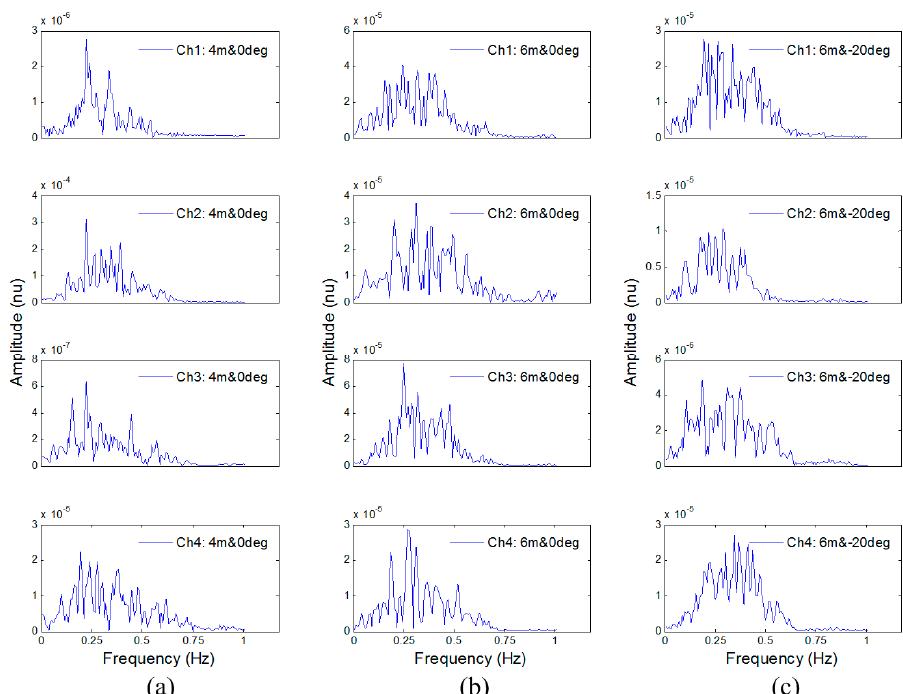
Figure 11. Results processed by the reference algorithm in [6]: the volunteer was at the position (4 m, 0°) ( a ); the volunteer was at the position (6 m, 0°) ( b ); and the volunteer was at the position (6 m, − 20°) ( c ). The rows from top to bottom corresponds to channel 1, 2, 3 and 4, respectively.